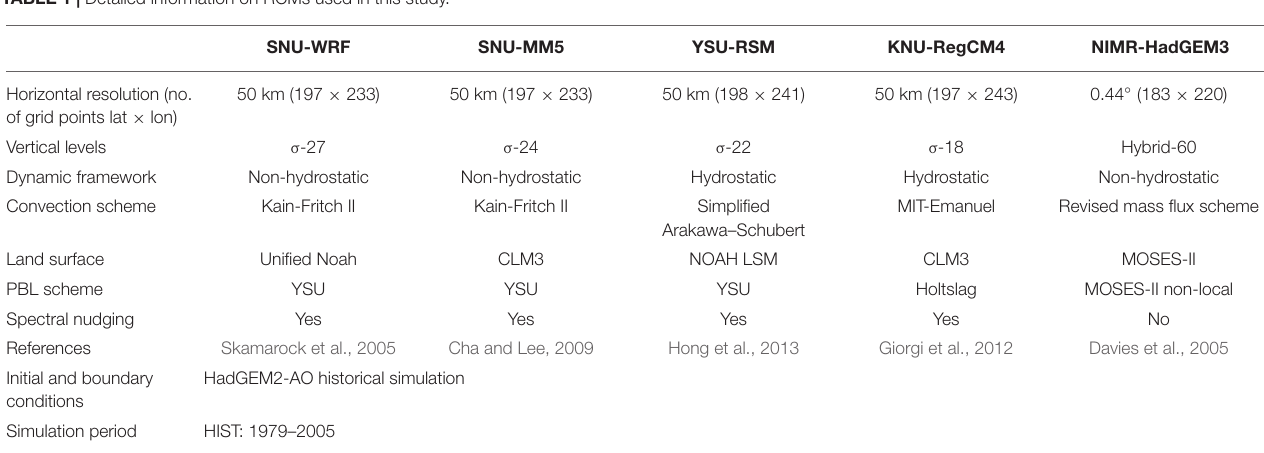
TABLE 1 | Detailed information on RCMs used in this